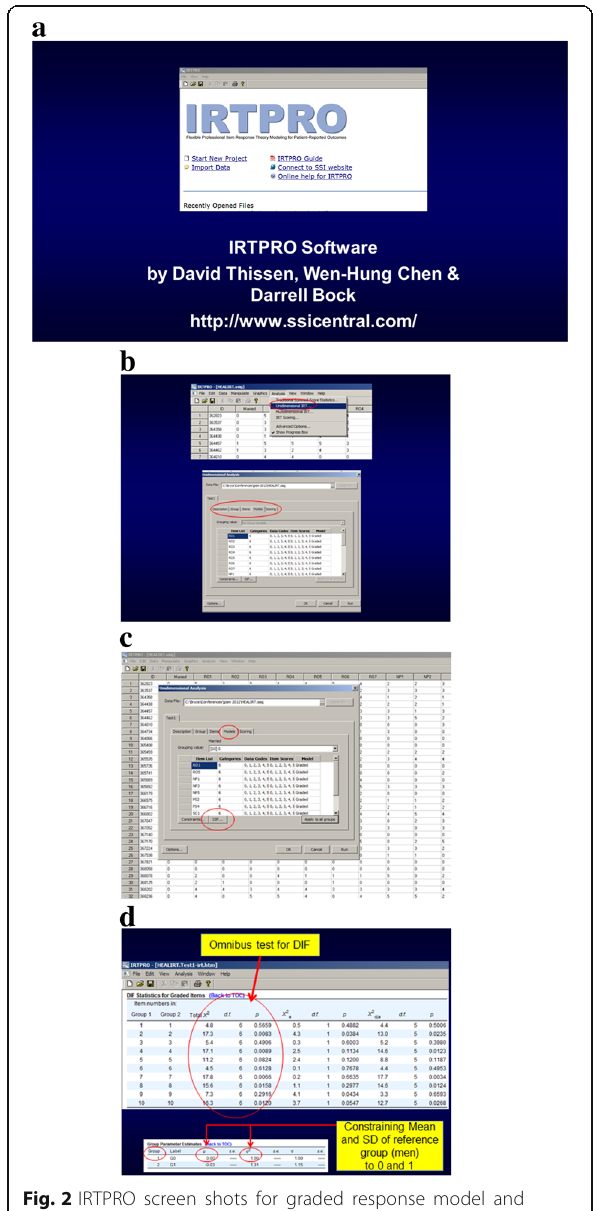
Fig. 2 IRTPRO screen shots for graded response model and differential item functioning. a introductory screen. b first part of sequence to enable DIF detection c second part of sequence to enable DIF d DIF